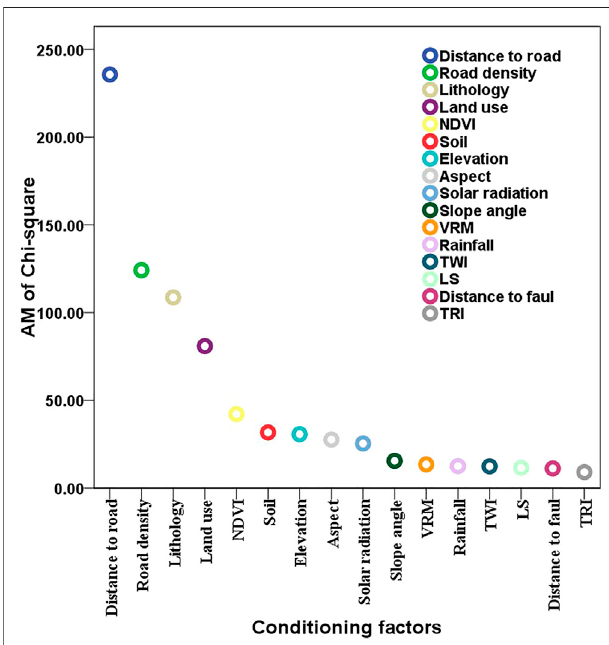
FIGURE4| Factorselectionusingthechi-squaretechniquewith10-fold